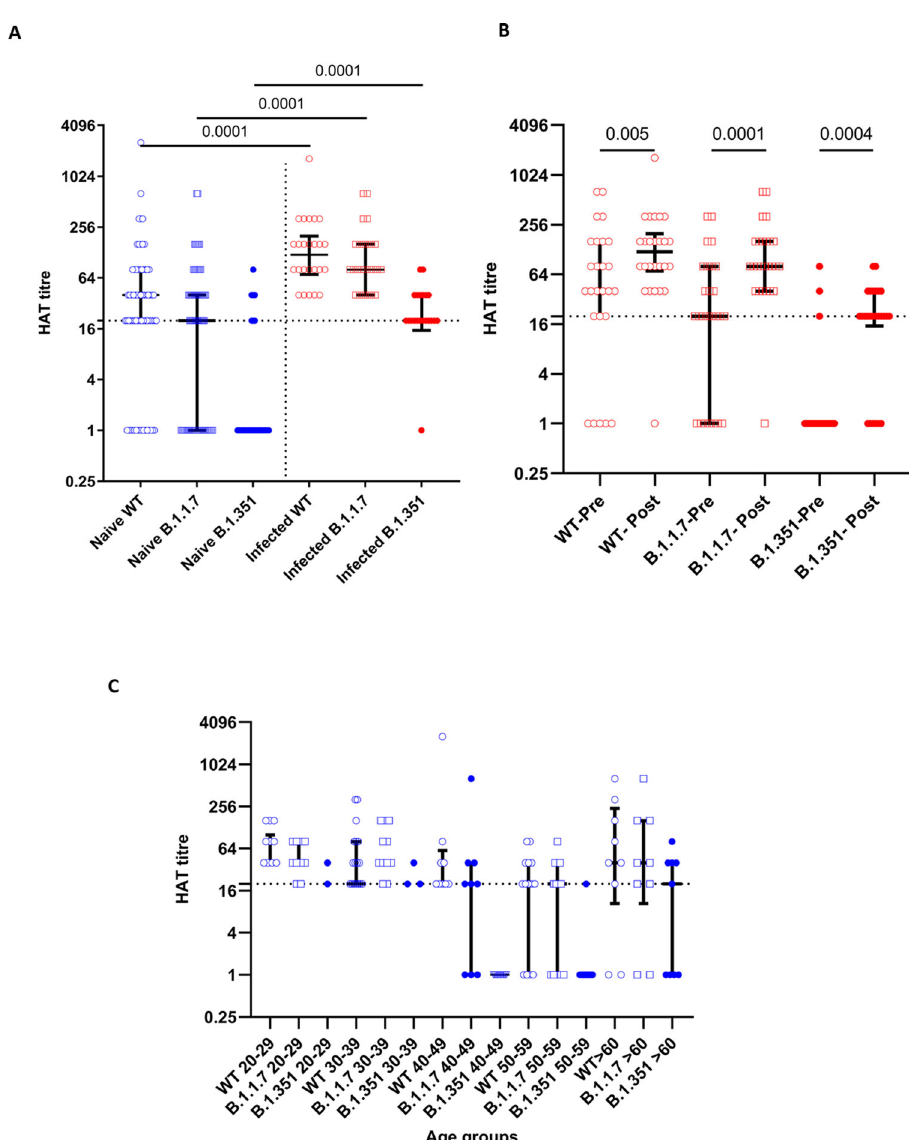
Fig. 2 Haemagglutination test to detect antibodies to RBD of the wild type (WT), B.1.1.7 and B.1.351 in patients who were naïve and previously infected following a single dose of the AZD1222. The HAT titres for the WT, B.1.1.7 and B.1.351 were measured in naïve individuals ( n = 68) (blue) and previously infected individuals ( n = 26) (red) 28 – 32 days following the vaccine ( A ). The HAT titres were measured in previously infected individuals at the baseline and following vaccination for the WT, B.1.1.7 and B.1.351 ( n = 26) ( B ). The HAT titres were measured following a single dose in previously naïve individuals in different age groups (20 – 29 years = 13, 30 – 39 years = 25, 40 – 49 years = 8, 50 – 59 years = 13, >60 years = 9) ( C ). The black dotted line indicates the positive cut for the HAT. The Wilcoxon matched pairs signed-rank test was used to compare the means of the HAT titres before and after the vaccine. All tests were two sided. The Mann – Whitney U test (two tailed) was used to calculate the differences in the means in the HAT titres in the infected and naïve individuals. Data are presented as median values ± interquartile ranges as